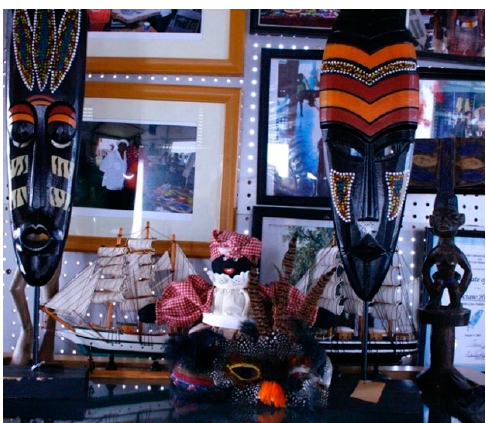
Figure 1. Ronald W. Lewis’s exhibit on the transatlantic slave trade on display at his museum, the House of Dance & Feathers in the Lower Ninth Ward of New Orleans/Bulbancha. Photograph courtesy of the Neighborhood Story Project.